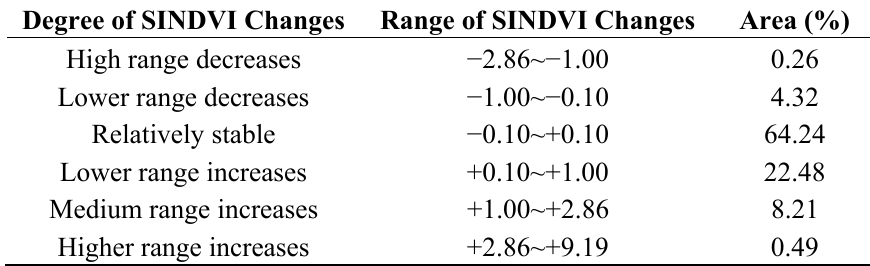
Table 3. Area statistics of seasonally integrated normalized difference vegetation index (SINDVI) changes in the Ejin Oasis between 2000 and 2011.